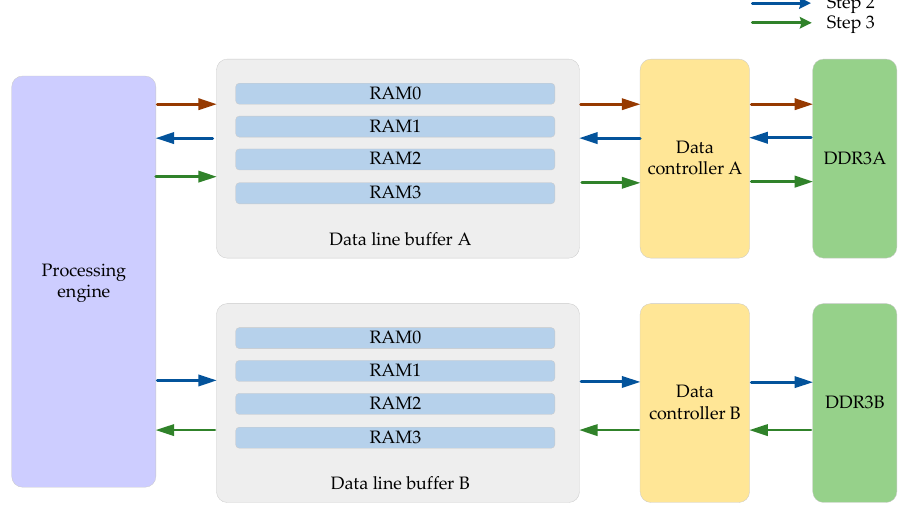
Figure 13. Schematic diagram of dual-channel pipeline